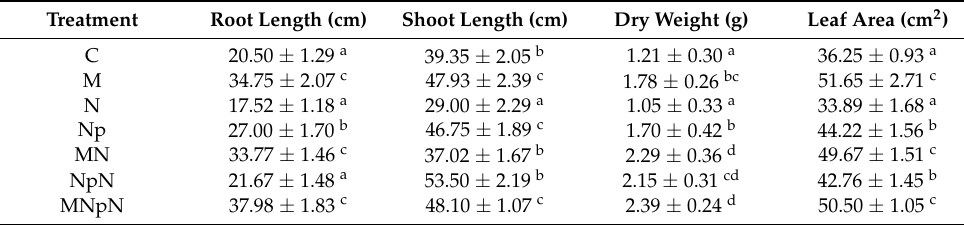
Table 3. Effect of mycorrhizal inoculation and n-HAP on the growth of 56-day-old tomato plant infected with M. incognita